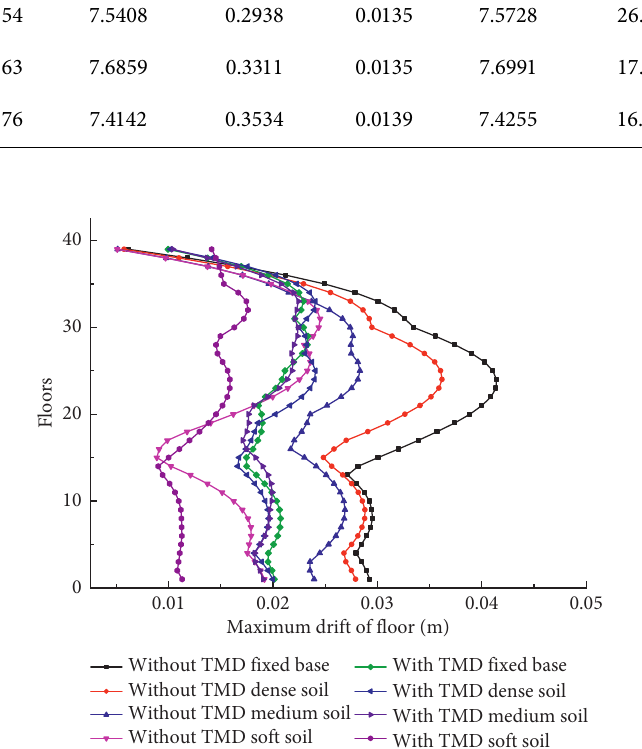
Figure 10: Tangshan earthquake maximum drift of floor comparison chart.